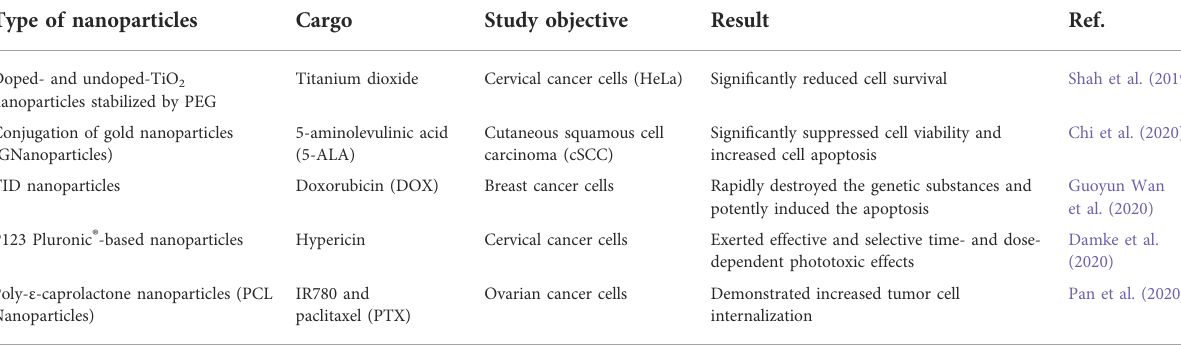
TABLE 1 Recent studies regarding the application of nanoparticles to